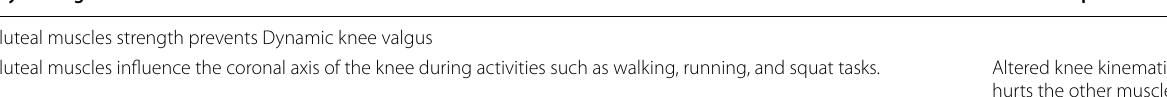
Table 2 Clinical implications Key finding from the review Clinical implications Gluteal muscles strength prevents Dynamic knee valgus Gluteal muscles influence the coronal axis of the knee during activities such as walking, running, and squat